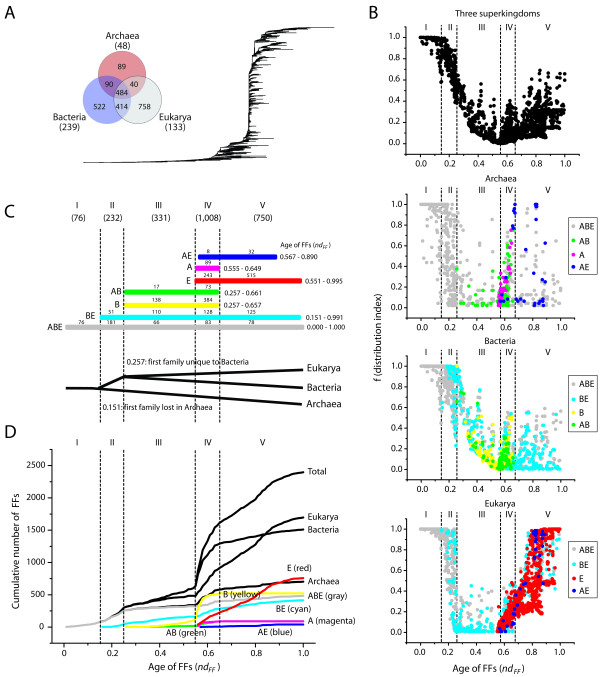
A timeline of domain appearance in the protein world. (A) Phylogenomic tree of FF domain structures (tree length = 177,864; CI = 0.030; RI = 0.749; g1 = -0.070) reconstructed from a genomic census of 2,397 FFs in 420 proteomes of free-living organisms (all 420 characters were parsimoniously informative). Terminal leaves are not labeled because they would not be legible. The Venn diagram shows diversity of FFs in the three superkingdoms. (B) Five phases in the evolutionary timeline of appearance of FFs in all three superkingdoms (top), and in Archaea, Bacteria, and Eukarya. Individual plots show the relationships of f (distribution index) and nd values (age of FFs). (C) The seven horizontal bars indicate nd ranges for taxonomic groups of FFs that are unique to individual superkingdoms (A, B, E) or shared by two (AB, BE, AE) or all (ABE) superkingdoms. The total number of FFs emerging in each phase is indicated in parentheses. The numbers labeled above bars indicate diversity of FFs belonging to taxonomic groups in each phase. (D) Cumulative frequency distribution of FFs along the timeline of domain structures.